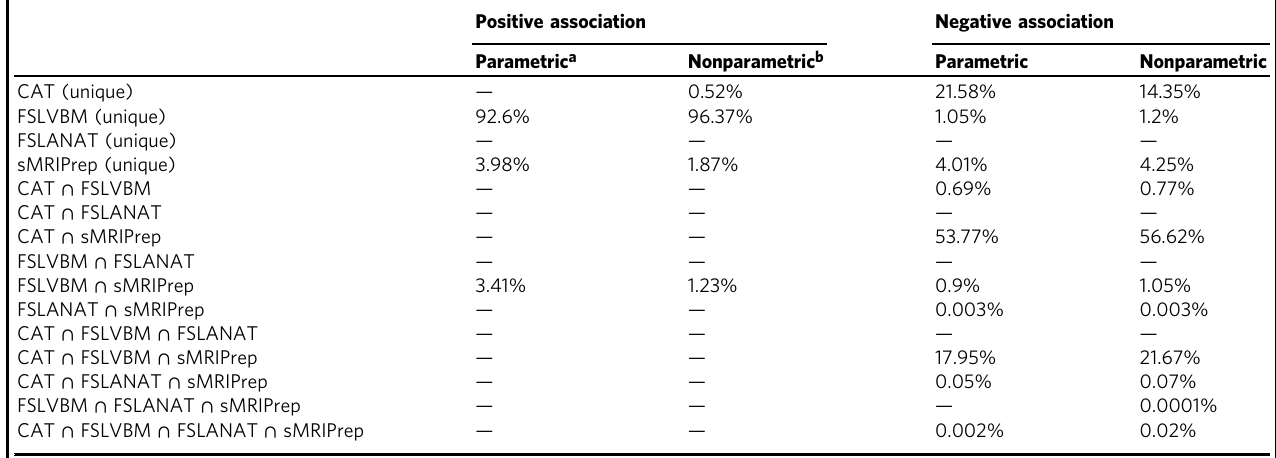
Table 2 Percent overlap of age-associated GMV changes between the